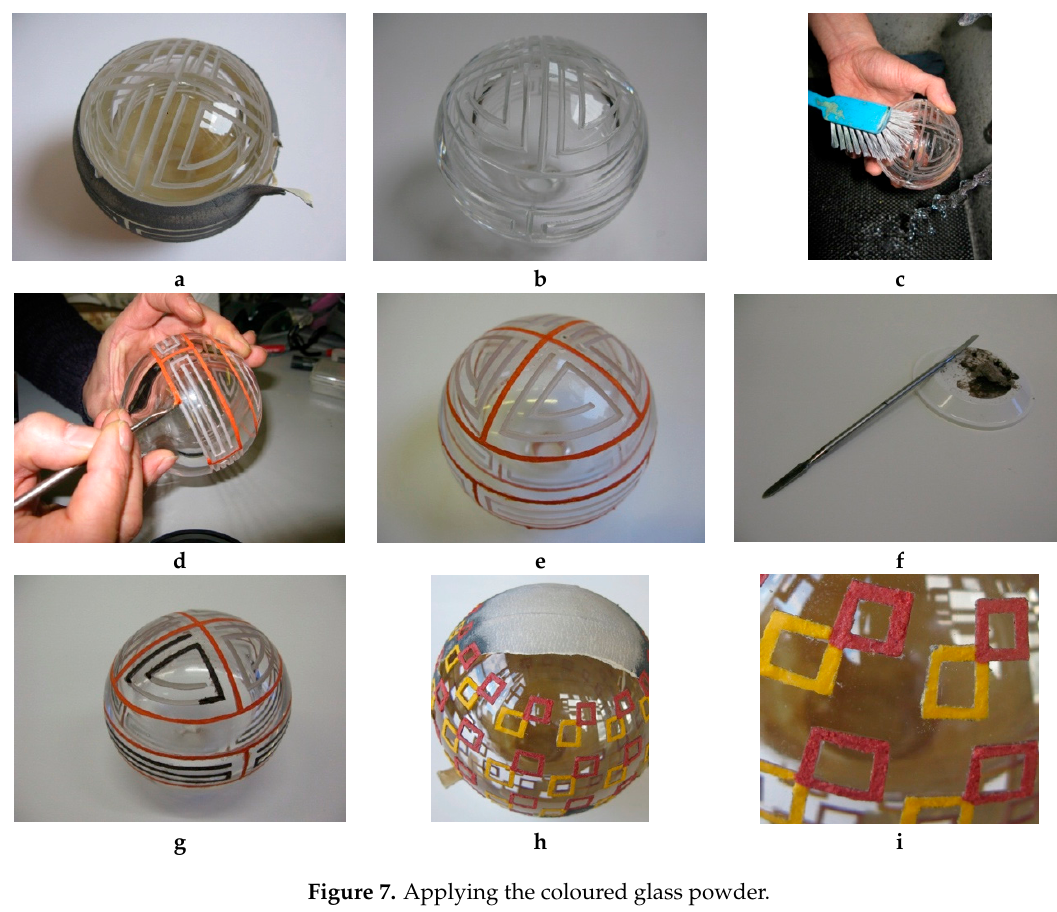
Figure 7. Applying the coloured glass powder.